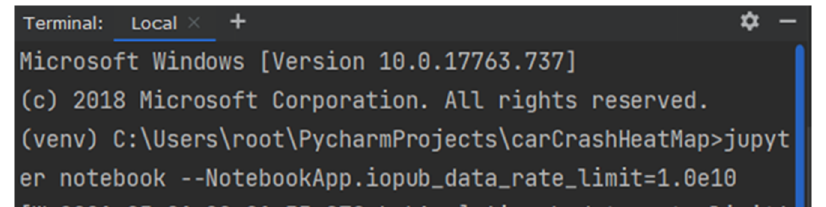
Figure 3. Running the Jupyter environment to work with the dataset.